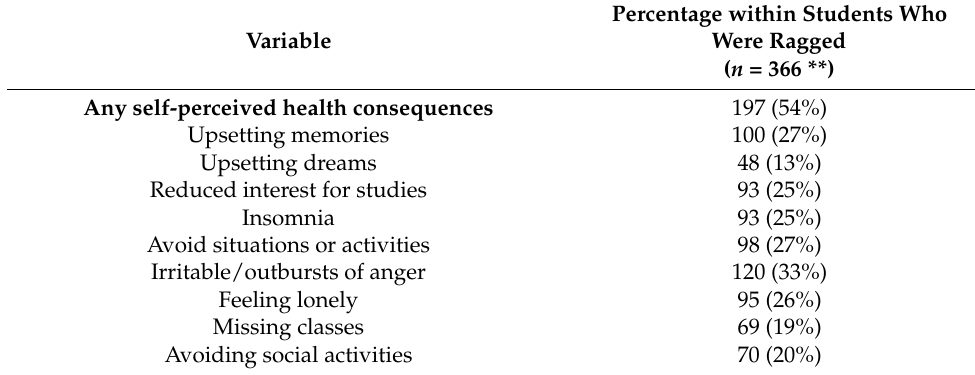
Table 3. Self-perceived health consequences and help-seeking behavior reported by students who had experienced any of type ragging in the second and third year in the faculties of medicine and